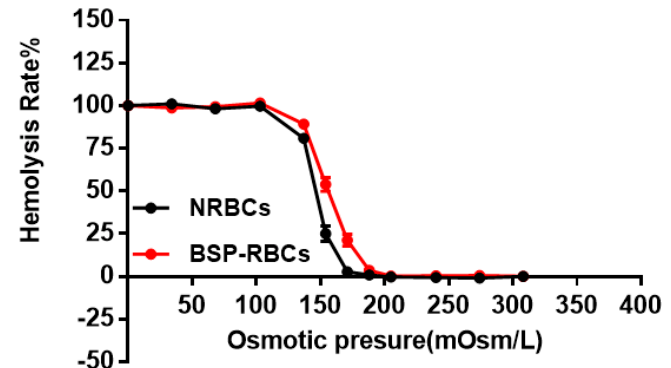
Figure 3. Osmotic fragility curves of NRBCs and BSP-RBCs. Data are represented as mean ± SD, three samples were used in each group.